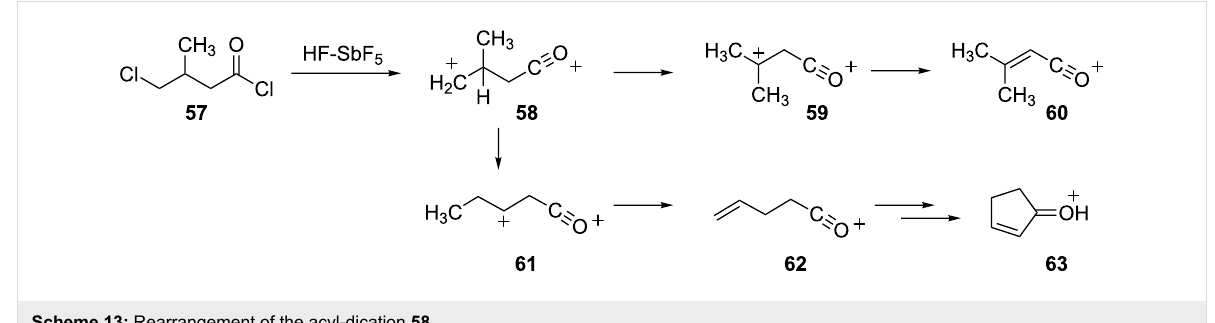
Scheme 13: Rearrangement of the acyl-dication 58 .